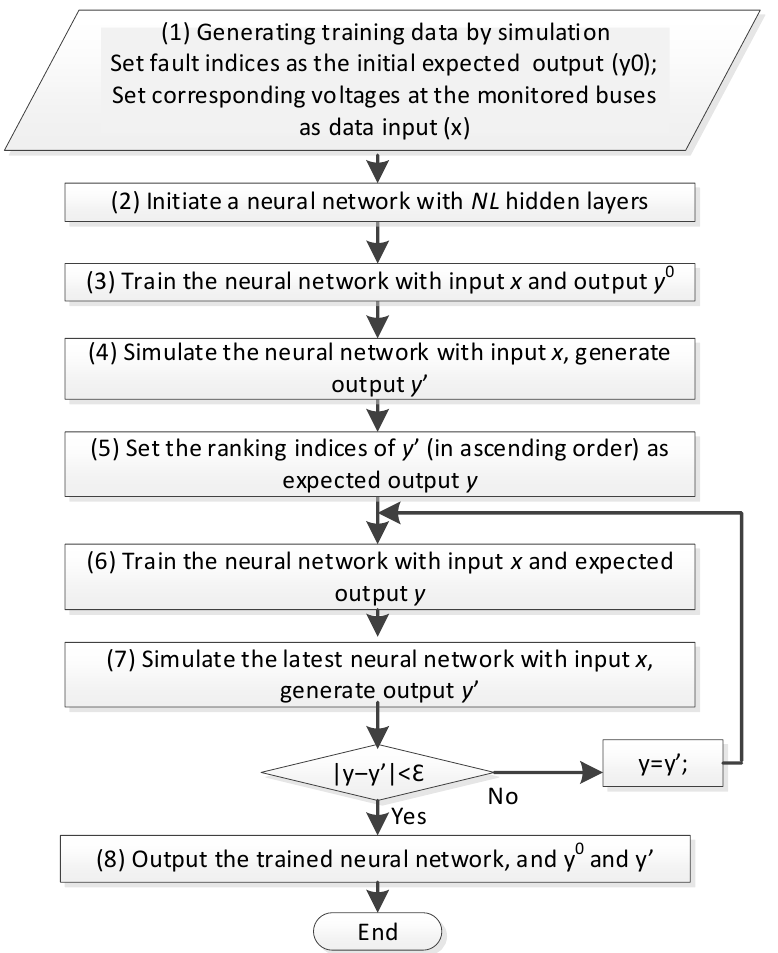
Figure 4. Procedure of obtaining the neural network and corresponding representative fault indices.